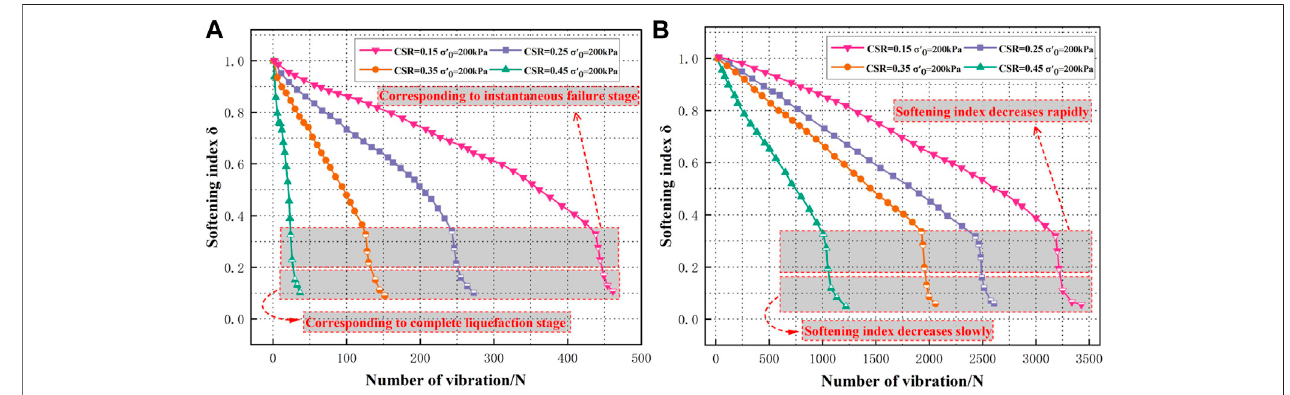
FIGURE11| EffectofdifferentCSRonsofteningindexofPGunderdifferentvibrationcondition: (A) unidirectionalvibrationscondition; (B) bidirectionalvibrationscondition.